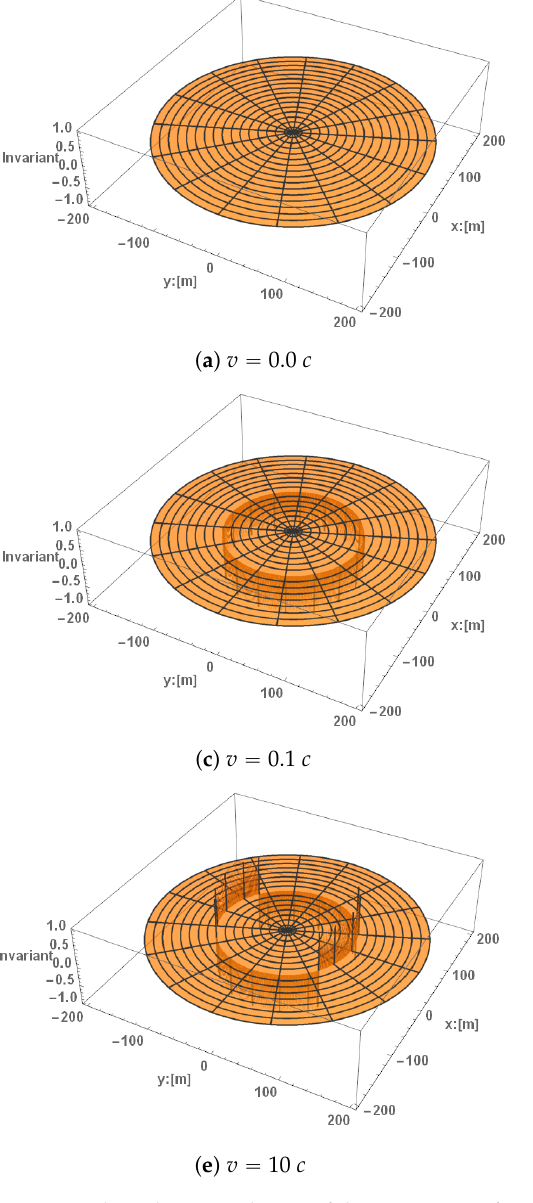
Figure A7. The velocity evolution of the r 1 invariant for the Natário warp drive at a constant velocity. The other parameters are set to σ = 50,000 1 and ρ = 100 m. Equation (11) is in natural units, so the speed of light was normalized out of the m equation. The factor of c was included in these captions to stress that the plots are of multiples of the speed of light. Their units are ms ´ 1